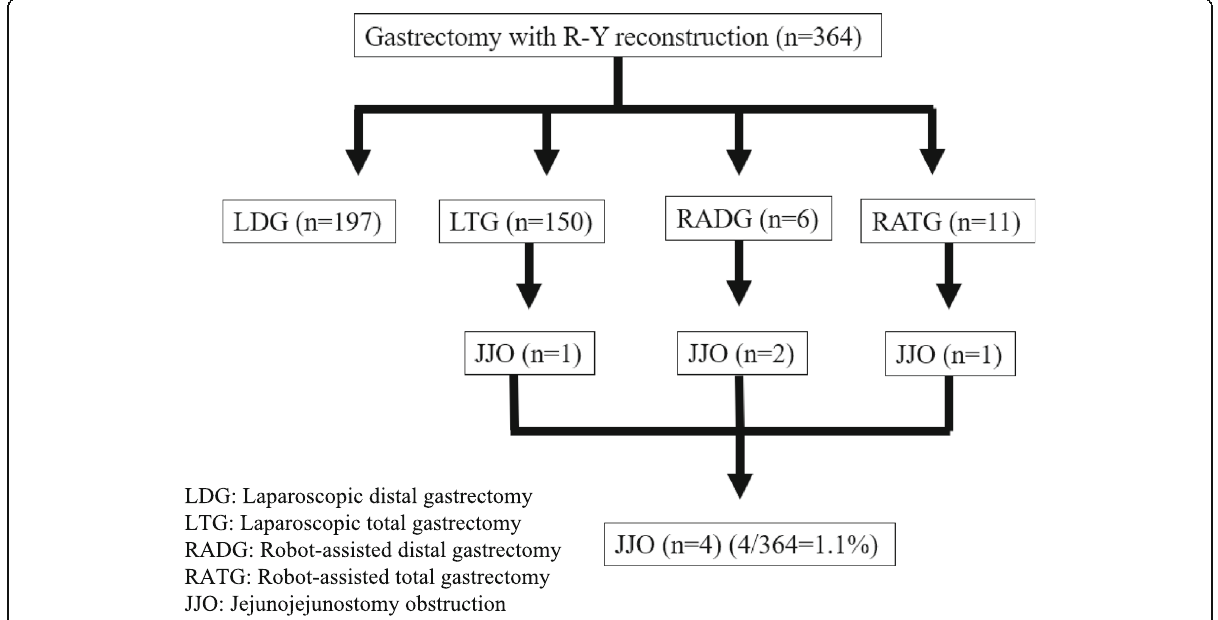
Fig. 5 Incidence of jejunojejunostomy after gastrectomy with Roux-en-Y reconstruction at our